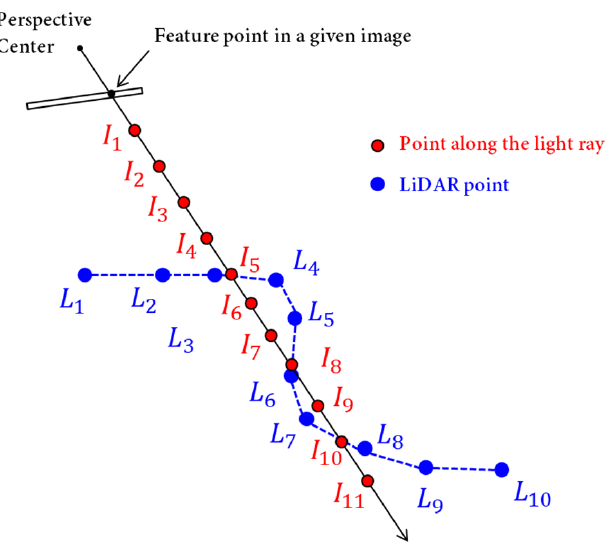
Figure 7. Schematic illustration of the forward projection algorithm: starting from I 1 , I 5 is the first point that fulfills the distance criteria; although I 8 and I 10 also meet the criteria, the corresponding surfaces are not visible.